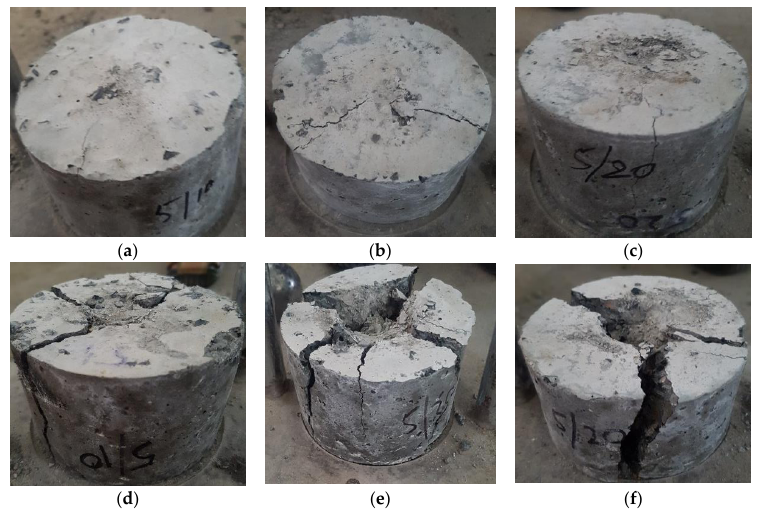
Figure 17. Cracking pattern for specimens with various dosages of R1 rubber: ( a ) initial crack for 10% R1, ( b ) initial crack for 20% R1, ( c ) initial crack for 30% R1, ( d ) final crack for 10% R1, ( e ) final crack for 20% R1, ( f ) final crack for 30% R1.